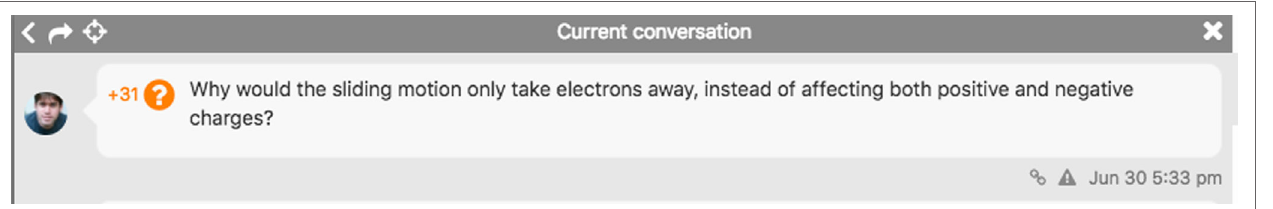
FigUre 4 | Upvoting of questions in Perusall (note: the depicted individual provided written informed consent for the publication of their identifiable